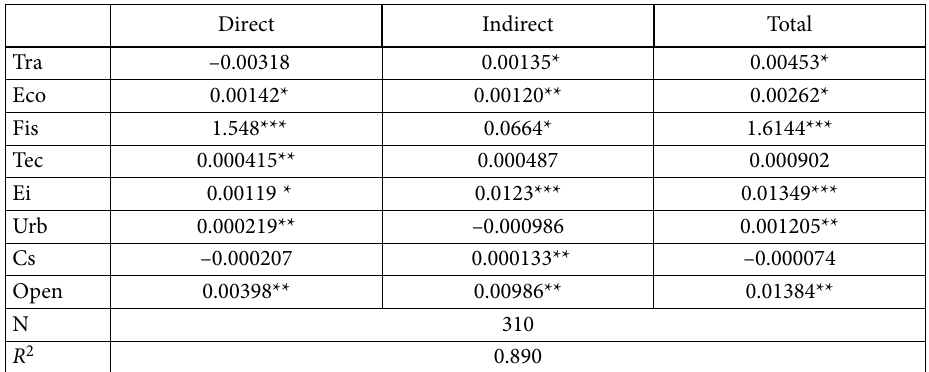
Table 11. SDM model effect